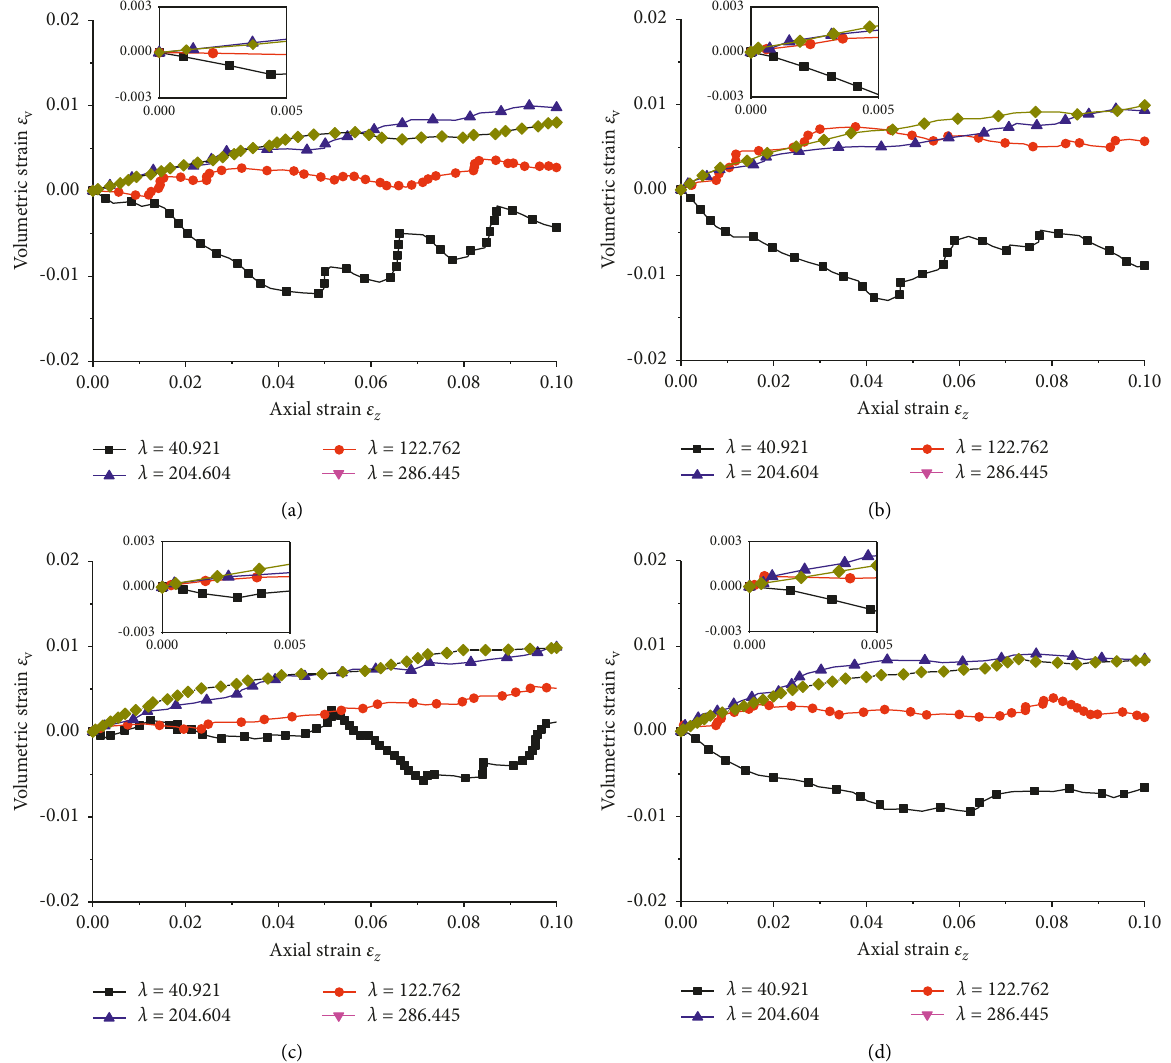
Figure 9: Volumetric strain-axial strain relationship of RVEs with various heights and particle sizes. (a) RVEs with various heights at 0 g. (b) RVEs with various particle sizes at 0 g. (c) RVEs with various heights at 5 g. (d) RVEs with various particle sizes at 5